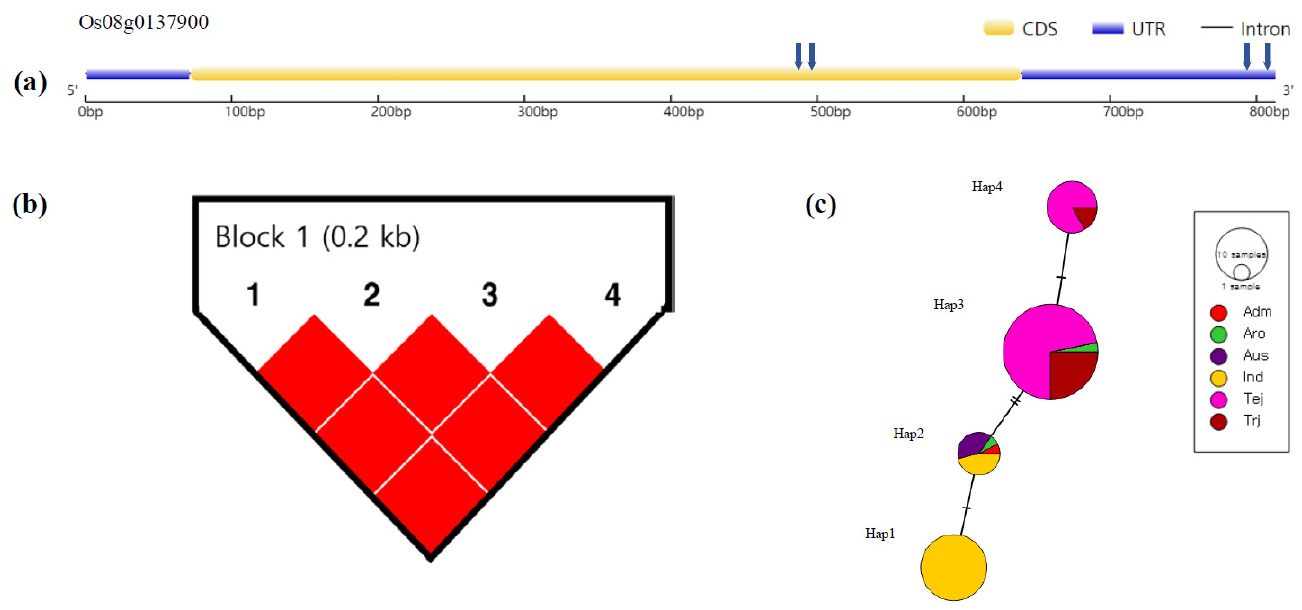
Figure 8. Haplotype analysis of Os08g0137900 . ( a ) Schematic representation of gene structure and SNPs positions in Os08g0137900 . Yellow and blue blocks represent exon and untranslated region (UTR), blue vertical bars represent SNPs. ( b ) Linkage disequilibrium (LD) analysis of SNPs in Os08g0137900 . D’ was used to indicate LD level, with LD blocks defined using the Confidence Intervals function in the analysis software. Red blocks indicate complete LD between each SNP. ( c ) Haplotype variation analysis. Colors indicate rice subspecies as indicated in the legend. Circle size indicates the number of varieties in each Hap. Traverse lines represent the extent of variation between four haplotypes. Table 6. Results of haplotype analysis of Os08g0137900 .